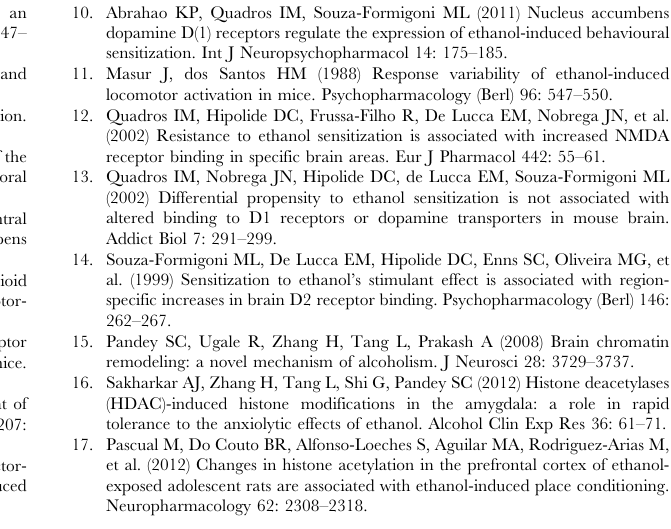
Figure S3 Expression of EIBS is not associated with ethanol-induced neurotoxicity. During 10 days, mice re- ceived daily i.p. injections of saline or ethanol (2 g/kg) solution. At day 17, mice were challenged with saline or ethanol (2 g/kg) solution and transcardially perfused 30 min later to perform immunohistochemistry (n= 4 per group). ( a ) Photomicrographs illustrating the immunolabelling for NeuN in the core of the Nac. The number of NeuN positive cells are represented as mean values ( 6 SEM) in the core ( b ) and in the shell ( c ) of the Nac or in the dorso-lateral ( d ) and dorso-medial ( e ) striatum. Nac, nucleus accumbens. Table S1 Functional classification of striatal epigenetic- related genes studied in acute, resistant and sensitized mice during EIBS expression phase. During 10 days, mice received daily i.p. injections of saline or ethanol (2 g/kg) solution. At day 17, 30 min after saline or ethanol challenge (2 g/kg), striata were isolated to perform real-time PCR (n= 4 per group).